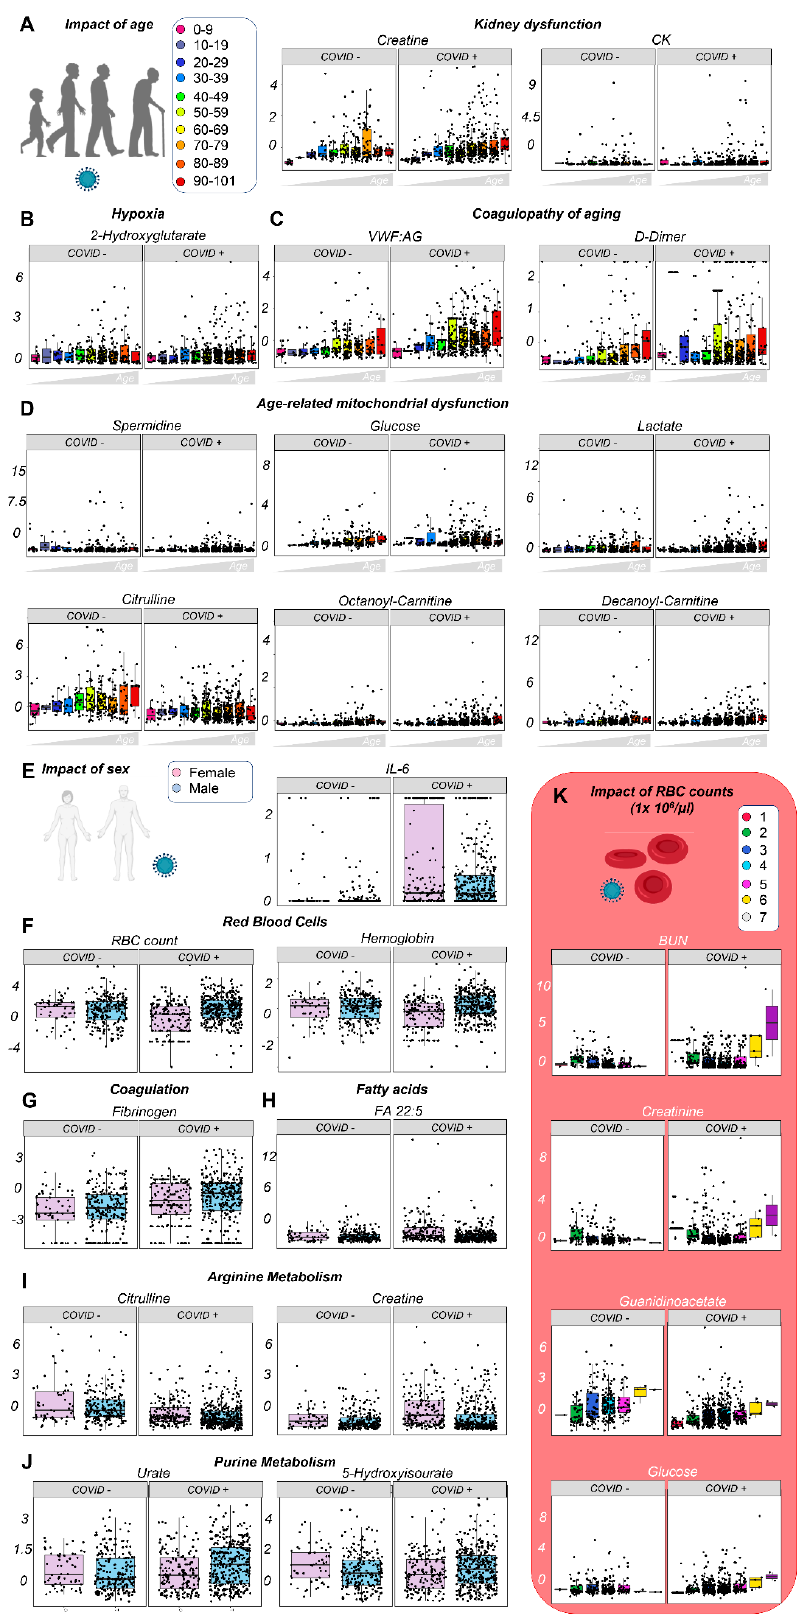
Figure 3. The impact of age and sex on the plasma metabolome of hospitalized patients with or without COVID-19. Patients were clustered into groups depending on their age ( A ).